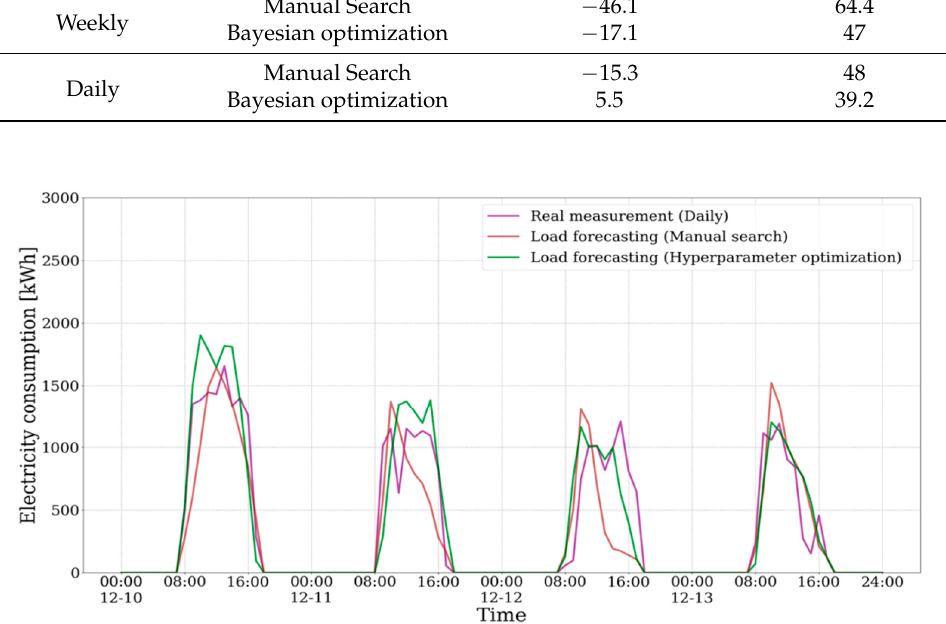
Figure 15. Load forecasting result with daily model and building